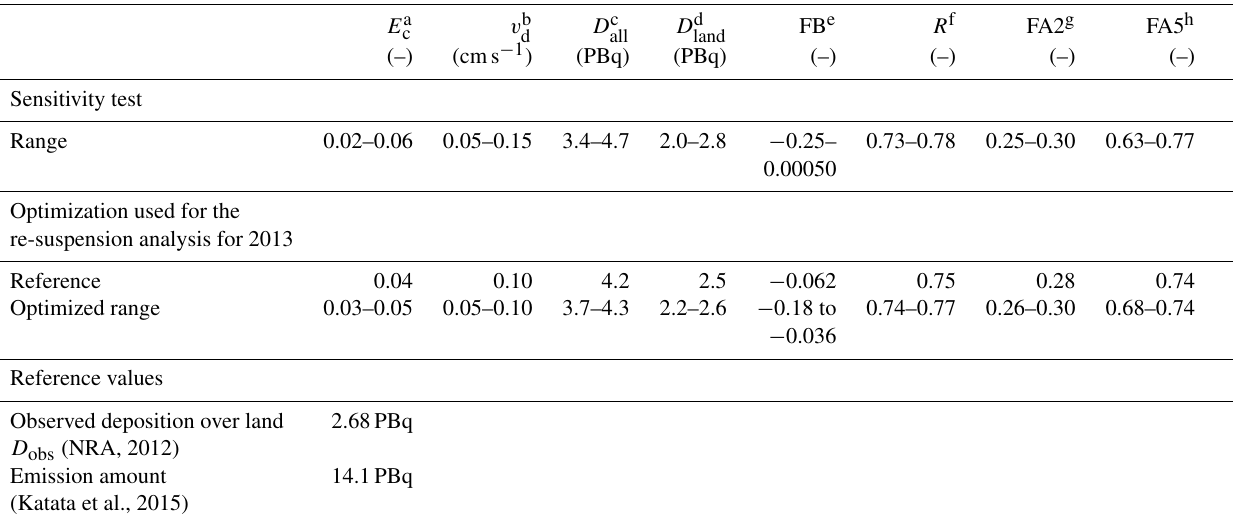
Table 2. 137 Cs budget and statistical analysis for the comparison of observed and simulated deposition data for March 2011.